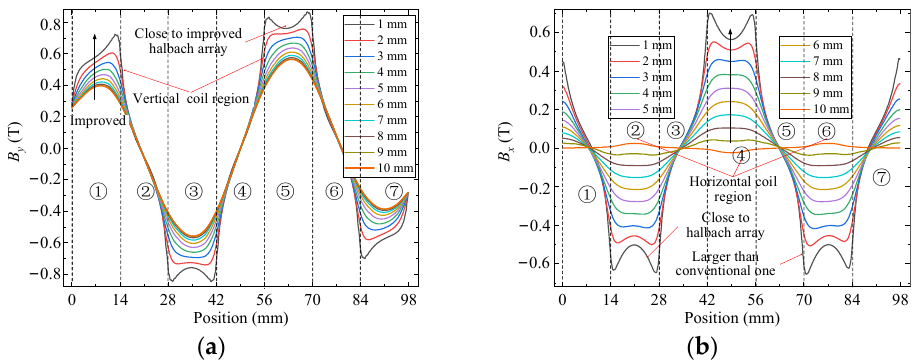
Figure 14. Airgap flux density distribution of improved halbach array scheme: ( a ) y component; ( b ) x component.